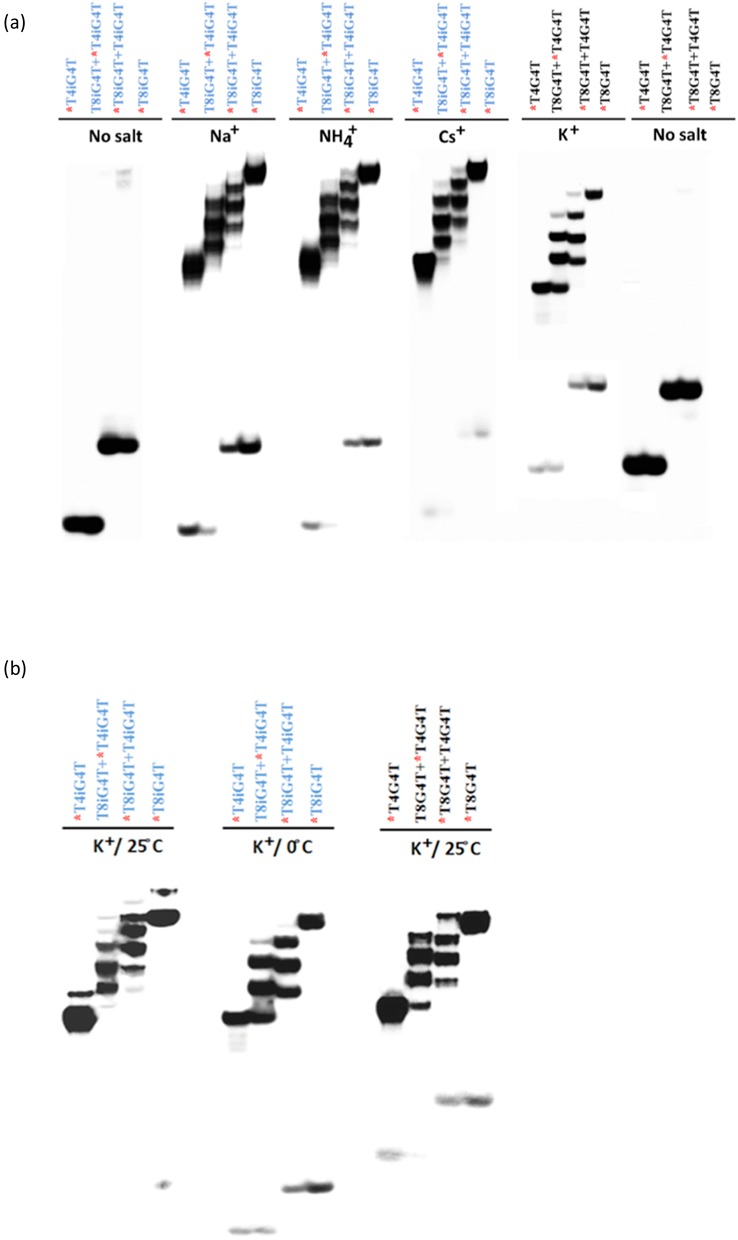
Native gel electrophoresis analysis of the multi-stranded products formed from incubation, with specific salt solutions, of 1:1 molar mixtures of 5′-T4G4T and 5′-T8G4T (labeled in black); or 5′-T4iG4T and 5′-T8iG4T (labeled in blue). Oligomers marked with a red asterisk are 5′-32P-labeled; those not so marked are not radiolabeled. (a) Incubations carried out at 25°C. (b) Incubations carried out at 25°C versus 0°C.